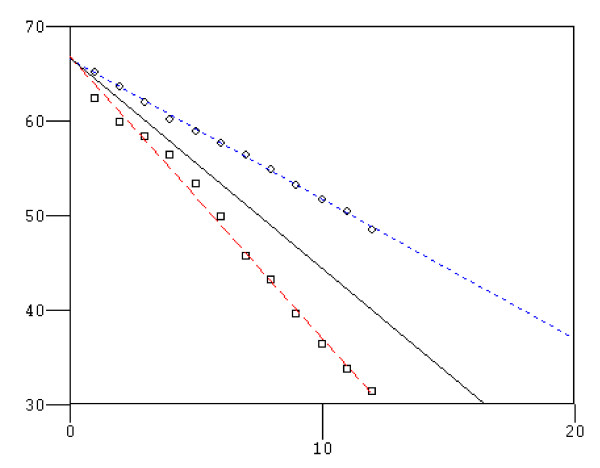
Slope of FVC% in 1 year between survivors of the groups 2 and 3. Blue line: Group 2 (12) (NPPV); Red line: Group 3 (4) (no NPPV). X axis: months, Y axis: FVC%. FVC% slope change per month in group 2 (1.52 ± 0.3) and group 3 (2.81 ± 0.8); p < 0.0001.